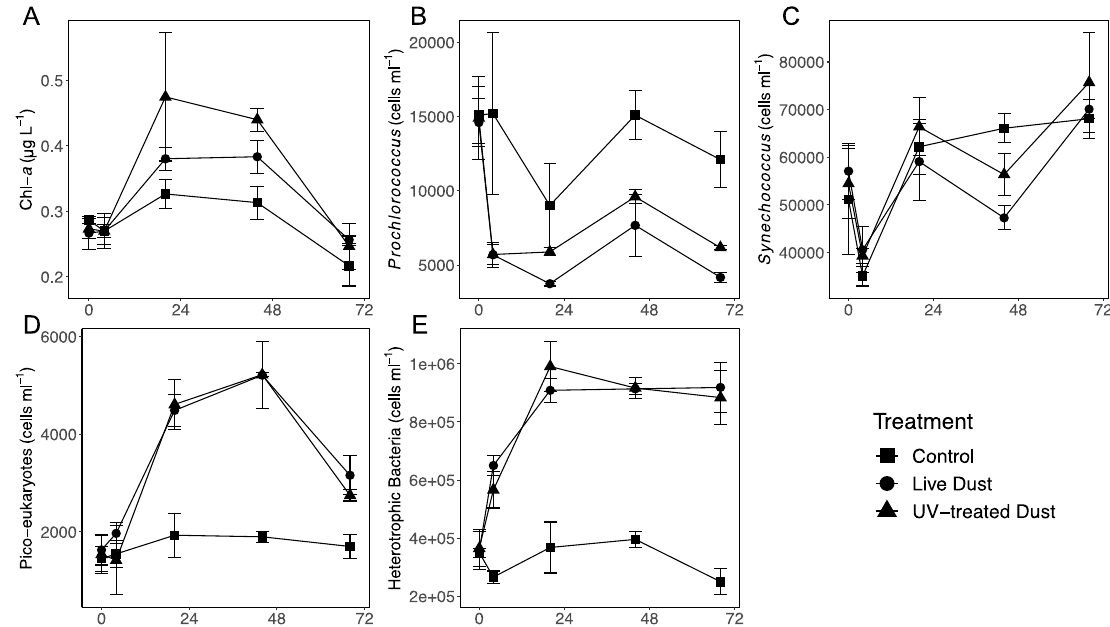
Figure 2. Temporal variability in Chl- a ( A ), Prochlorococcus ( B ), Synechococcus ( C ), picoeukaryotes ( D ), and heterotrophic bacteria ( E ) following 0.8 mg L − 1 of “live dust” (circle), “UV-treated dust” (triangle) or unamended controls (square). Data shown are the average ± SD ( n =